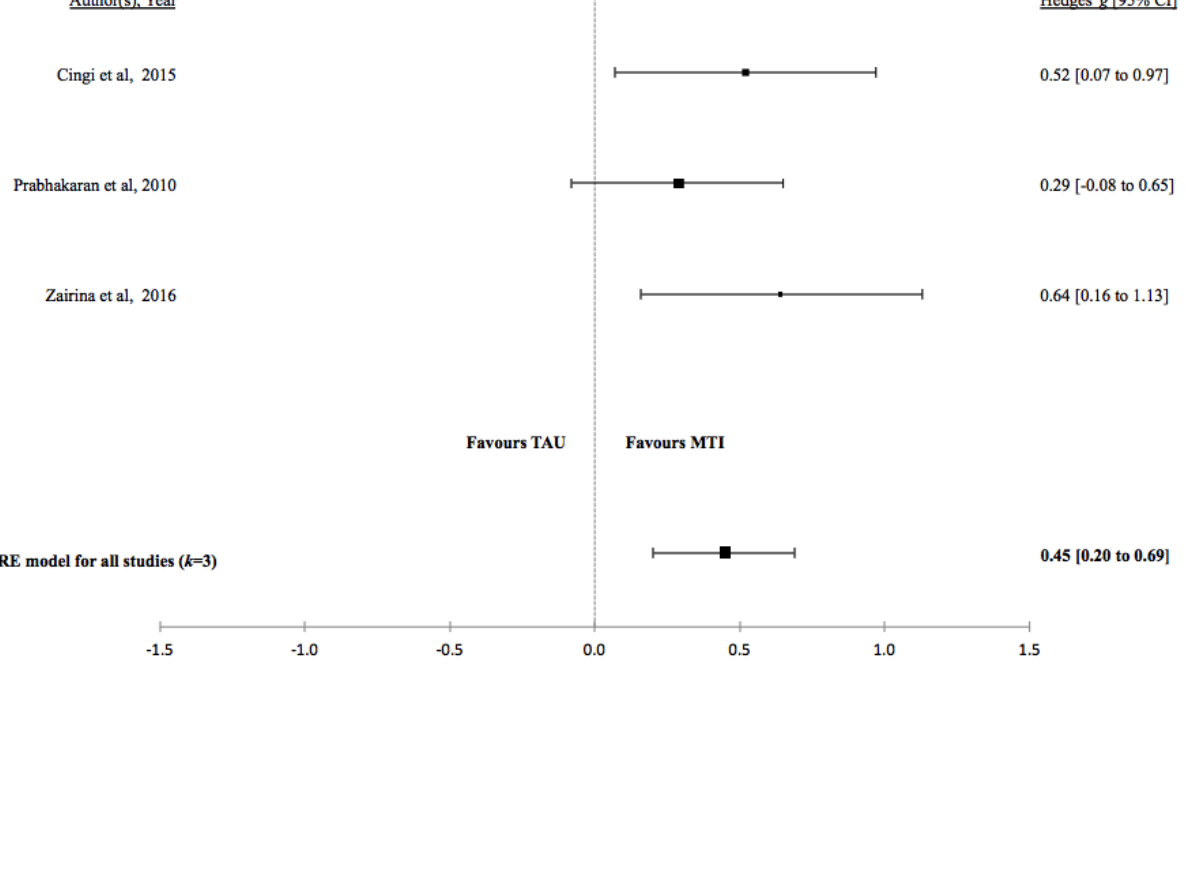
Figure 14. Forest plot of the standardized mean difference in well controlled asthma between MTI and standard treatment. MTI: mobile technology